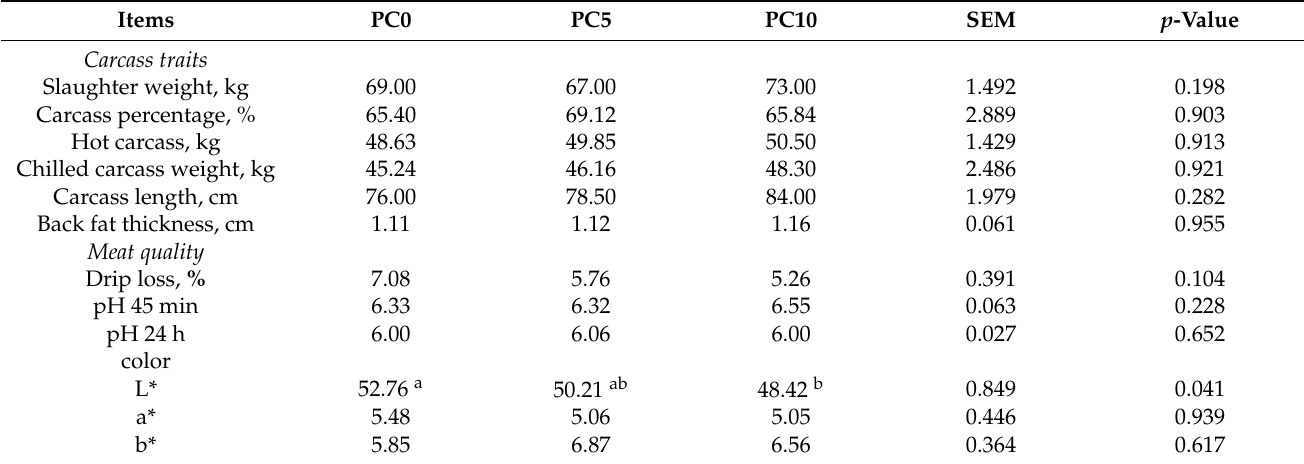
Table 4. Effect of dietary perilla cake supplementation on the carcass traits and meat quality of growing pigs. Items